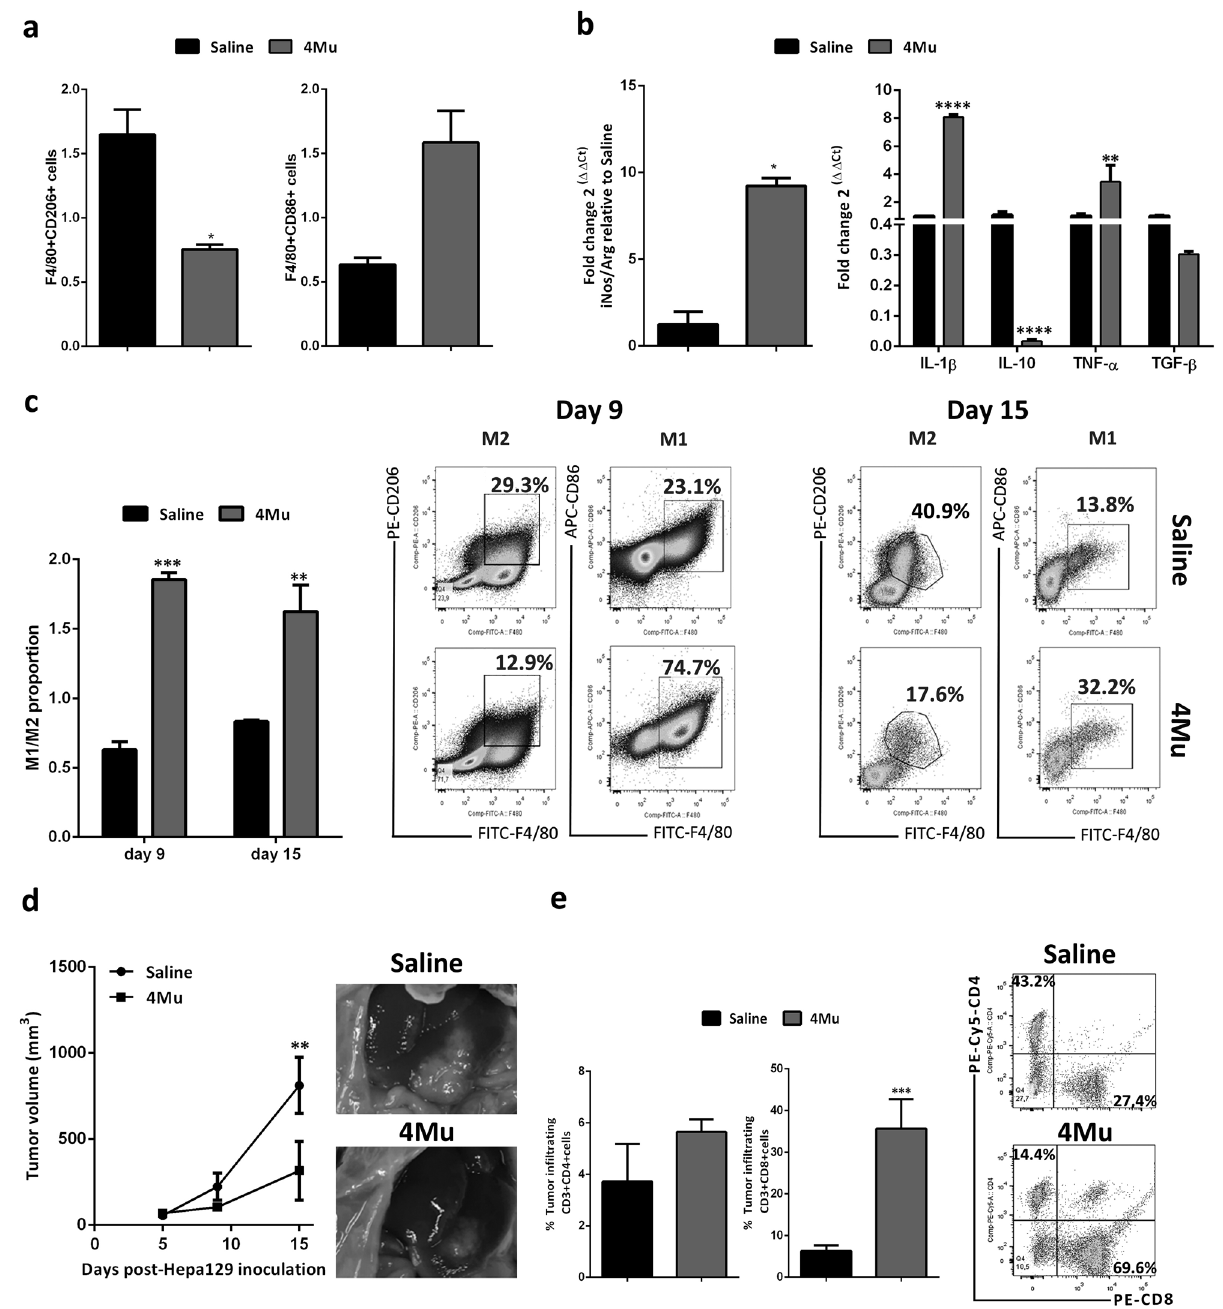
Figure 2. Type 1 macrophages phenotype was induced by 4Mu. ( a ) Peritoneal macrophages (pM ) were isolated from healthy mice (n = 4), cultured with 0.5 mM 4Mu for 72 h (n = 2), stained with anti-F4/80, ϕ anti-CD86 and anti-CD206 antibodies, and analyzed by flow cytometry. ( b ) iNOS/Arg1 ratio, and cytokine gene expression were measured in pM by qPCR (*p < 0.05; **p < 0.01; ****p < 0.0001 4Mu vs. saline; Mann– Whitney test and two-way ANOVA test respectively). ( c ) In vivo effects of 4Mu on pM in mice (n = 4/ ϕ group) with fibrosis-associated HCC. pM were obtained on day 9 (n = 2) and 15 (n = 2). Flow cytometry of ϕ F4/80 + CD86 + and CD206 + cells were analyzed, and the M1/M2 proportions were calculated as log2 (CD86 + / ϕ CD206 + );***p < 0.001, **p < 0.01 4Mu vs. saline, on days 9 and 15, respectively; Mann–Whitney test. ( d ) Tumor volume was measured on 4Mu treated and non-treated tumor-bearing mice at day 9 (p = 0.0571; ns) and at day 15 (**p < 0.01; Unpaired T Test). ( e ) Lymphocytic infiltration of HCC tumors. Flow cytometry analysis of CD4 and CD8 T cells. Percentage of CD8 + cells ***p < 0.001 4Mu vs. saline, Mann–Whitney Test. Data are expressed as the mean ± SEM. Flow cytometry was analyzed using BD Accuri C6 propietary software version 1.0.264.21 (www.Accur iCyto meter s.com) The experiments were repeated 2